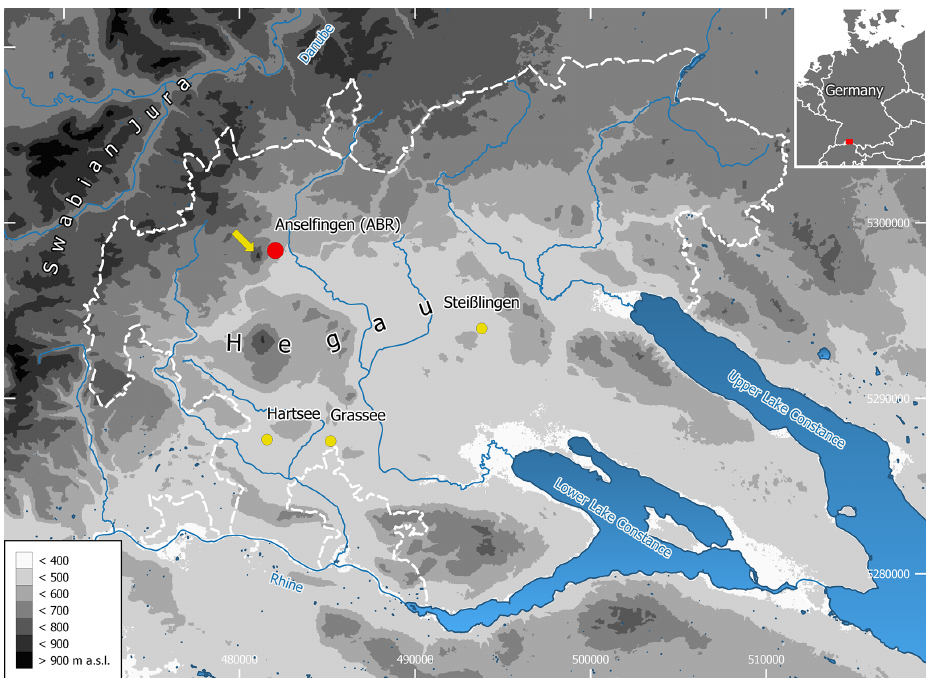
Figure 1. Study area (Hegau, SW Germany) with the Middle Bronze Age settlement site of Anselfingen (ABR, red dot), the pollen profiles (yellow dots) and Hohenhewen (yellow arrow). Coordinates are shown in the UTM 32N reference system; EPSG 25832. Image credits: NASA SRTM-1 V.3 (NASA JPL, NASA Shuttle Radar Topography Mission Combined Image Data Set. NASA EOSDIS Land Processes DAAC (2014); http://doi.org/10.5067/MEaSUREs/SRTM/SRTMIMGM.003, last access: 23 February 2018, (digital terrain model). © Lan- desanstalt für Umwelt Baden-Württemberg (2020); https://udo.lubw.baden-wuerttemberg.de, last access: 18 May 2020 (official water man- agement